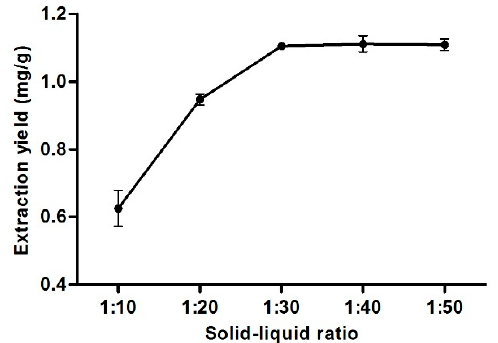
Figure 9. Effect of solid-liquid ratio on the extraction yield of rutaecarpine. La-Buta DES aqueous solution with 1:0.5 molar ratio containing 25% water was used as the solvent to extract at different solid-liquid ratios with ultrasound at 55 °C and 500 W for 40 min. The data represent mean ± S.D. of triplicated experiments.